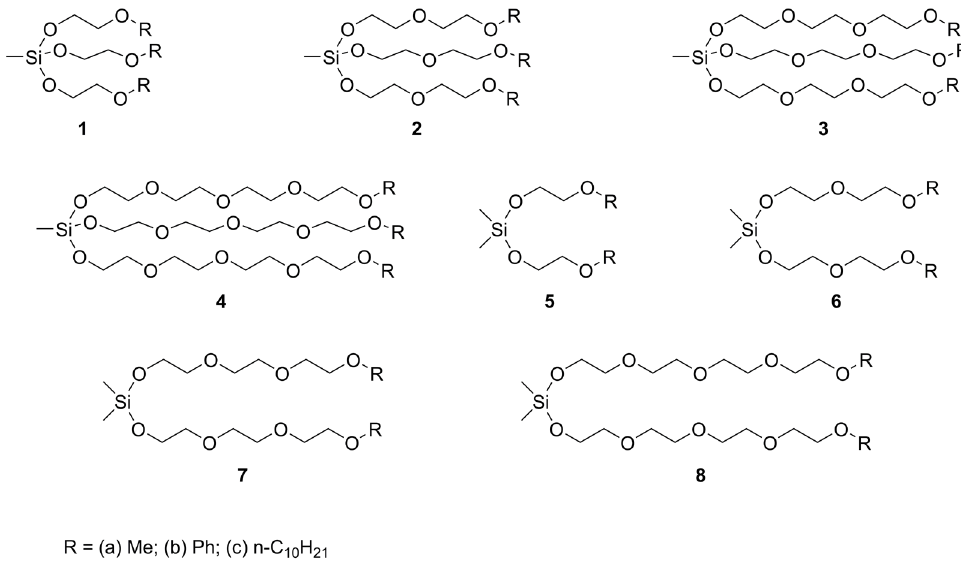
Figure 1. Structures of the studied ligands, alkoxysilane derivatives.